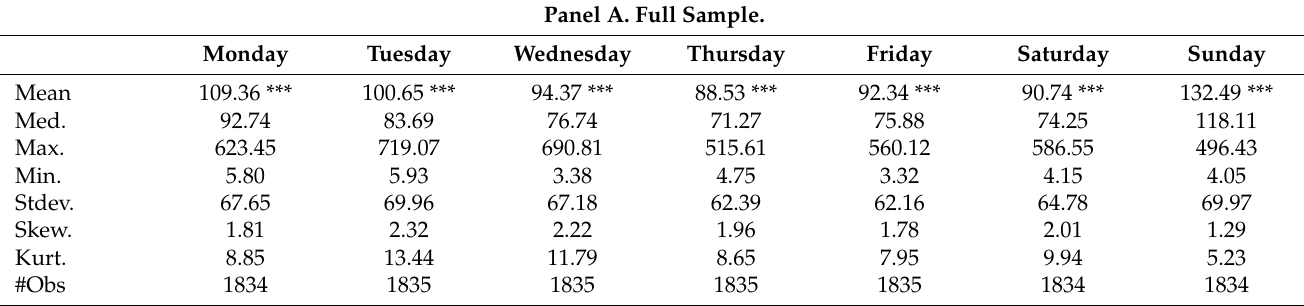
Table 11. Economic Uncertainty Policy across weekdays (Level). Panel A. Full